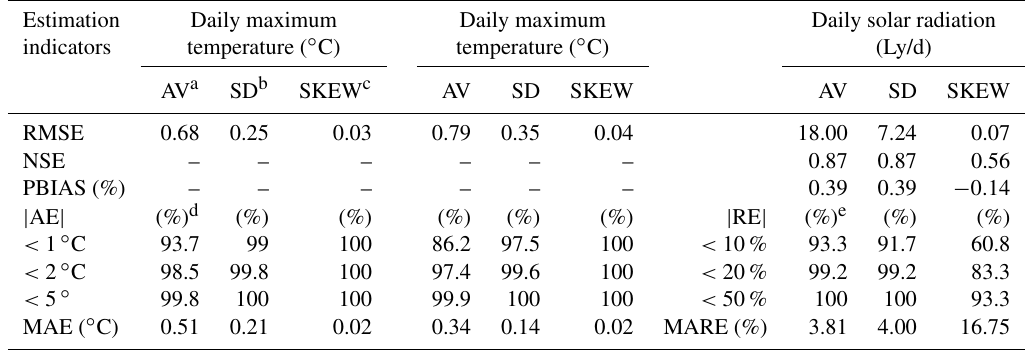
Figure 7. Comparison of the interpolation quality using ordinary kriging (OK) and universal kriging (UK) for CLIGEN temperature, solar radiation, and precipitation parameters in August, and the eighth parameter of TimePk. Table 4. Comparison of CLIGEN generated daily temperature and solar radiation based on observed input parameters and UK-interpolated ones. Estimation Daily maximum Daily maximum Daily solar